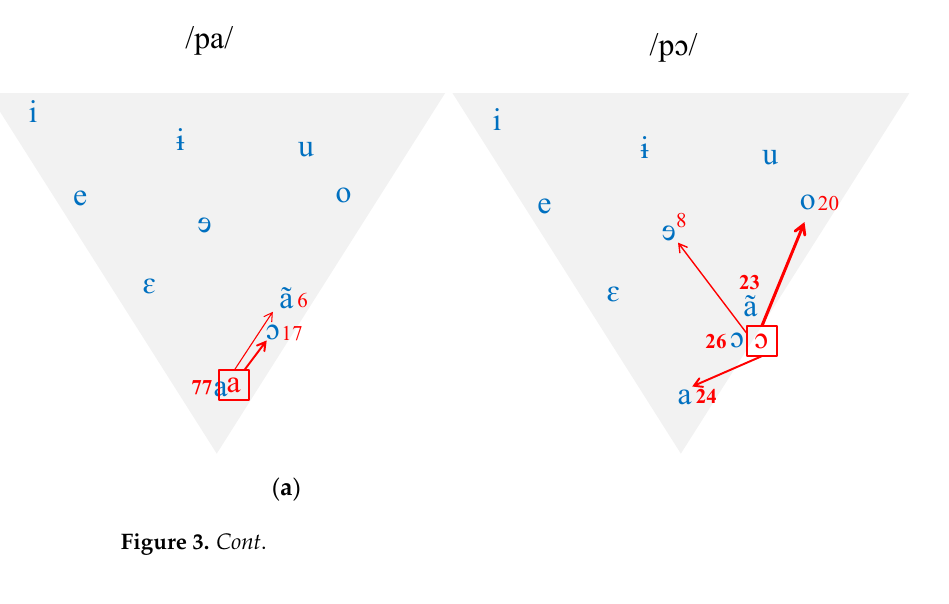
( b ) Figure 3. The percentage of Hñäñho words categorized as containing Hñäñho vowels by Hñäñho heritage speakers (HHS): ( a ) the/a - ɔ /vowel contrast; ( b ) the/o - ɔ /vowel contrast. On the other hand, MSM (Figure 4) categorized the Hñäñho vowel/ a /contained in the Hñäñho word/ pa /almost exclusively as the Spanish vowel/ a /(99%), whereas most in- stances of the Hñäñho vowel/ ɔ /contained in the Hñäñho word/ pɔ /were categorized by MSM either as the Spanish vowel/ a /(49%) or the Spanish vowel/ o /(47%). These findings have a few interesting implications. Firstly, the Hñäñho vowel/ ɔ /, as produced in the Hñäñho word/ pɔ /, seems to be acoustically perceived as a vowel roughly half-way be- tween the Spanish vowels/ a /and/ o /, which is not in line with previous observations that place the Hñäñho vowel/ ɔ /acoustically closer to the Spanish vowel/ a /. Secondly, the pro- portions of the Hñäñho vowel/ ɔ /categorized as the neighboring vowels were very similar for the HHS (24%, 26%, 20%, and 23% for/ a /,/ ɔ /,/ o /, and/ ã /, respectively) and for the MSM (49% and 47% for/ a /and/ o /, respectively), implying that both participant groups do not possess Hñäñho/ ɔ /in their vowel inventory, and, as a result, both participant groups cat- egorize this vowel as any other available neighboring sound in their vowel system during the categorization task. This would suggest that HHS do not maintain the same Hñäñho vowel system in this perception task as the older Hñäñho speakers who produced the words used in the present study (Figures 1 and 2).